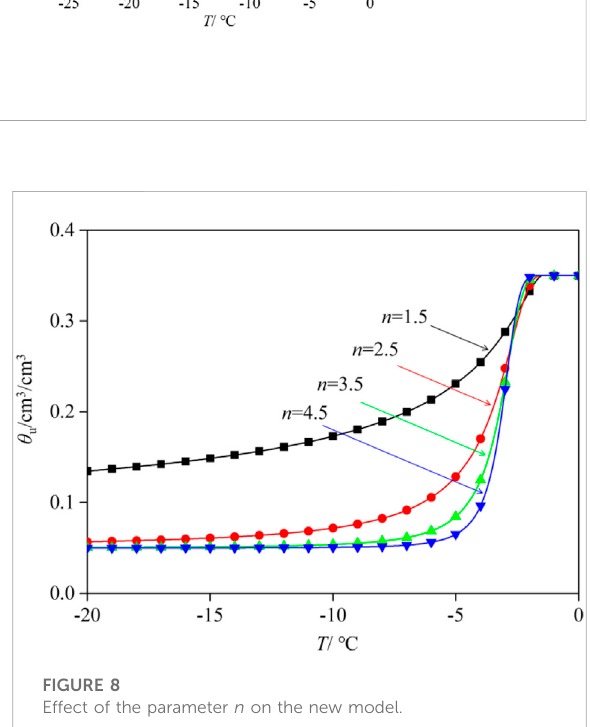
FIGURE 8 Effect of the parameter n on the new